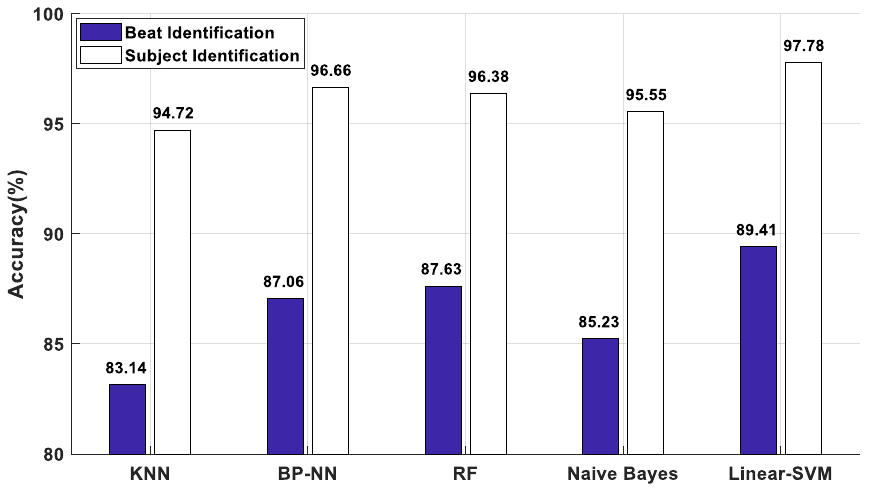
Figure 6. Comparison of different classifiers using the proposed method.